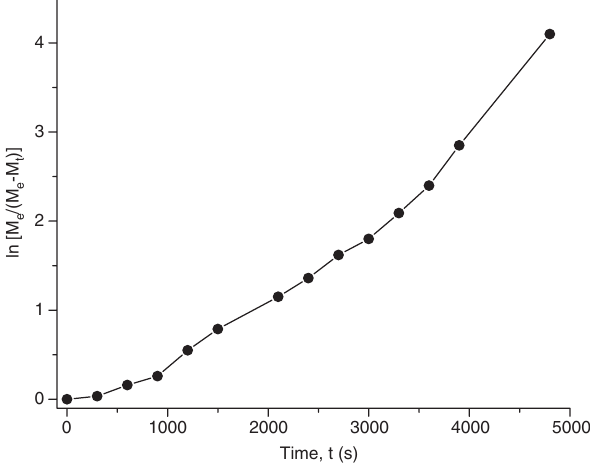
/( M - M )] and t e e t